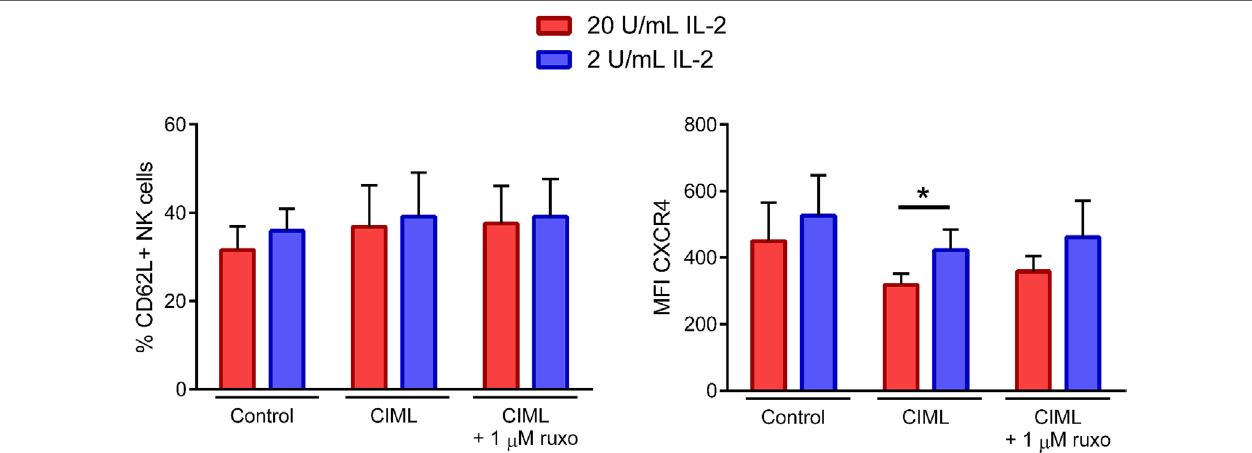
FigUre 7 | CD62L and CXCR4 expression of cytokine-induced memory-like (CIML) natural killer (NK) cells after the expansion phase. Bar graphs showing the percentage of CD62L + NK cells and the expression (MFI, median fluorescence intensity) of CXCR4 in control non-preactivated and CIML NK cells, preactivated in the presence and absence of 1 µM ruxolitinib, exposed to 2 or 20 U/mL IL-2 during the expansion phase ( n = 6). Bar graphs show the mean with SEM. Statistical differences were established with Wilcoxon matched-pairs signed rank test. * p <